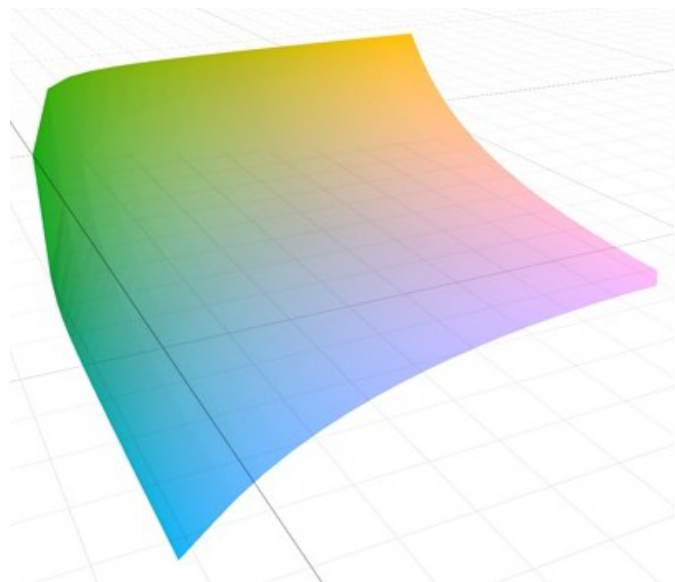
Figure 18. Anger + Fear—extraversion factor.